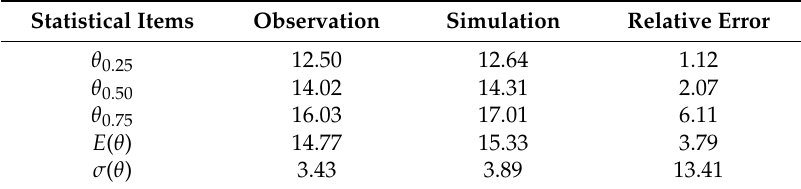
Table 7. Statistical characteristics of soil moisture θ in the calibration period (Unit: